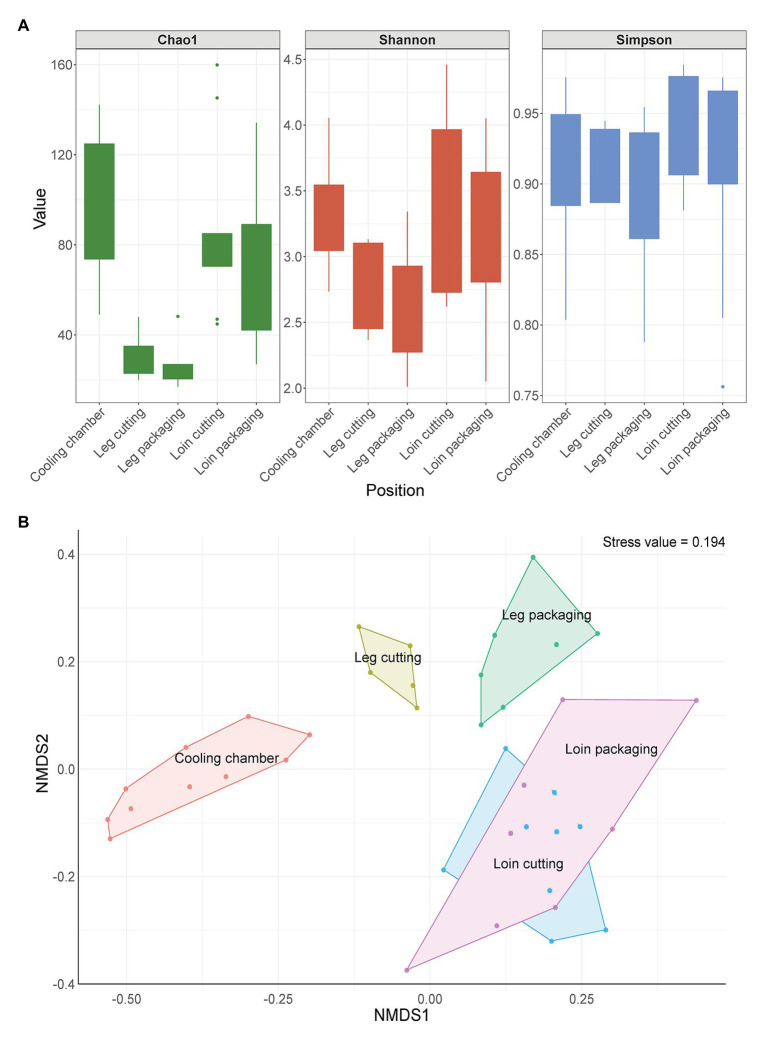
(A) Change in alpha diversity indices of meat samples over time. Boxes indicate the interquartile range (from 75 to 25th) of the data. Whiskers extend to the most extreme value within 1.5 times interquartile range and dots represent outliers beyond that range. (B) Non-metric multidimensional scaling (nMDS) plot of Bray-Curtis distances based on 16S ribosomal RNA (rRNA) gene libraries obtained from meat samples. Each point represents values from individual libraries with colors expressing meat samples from different positions along the processing line.